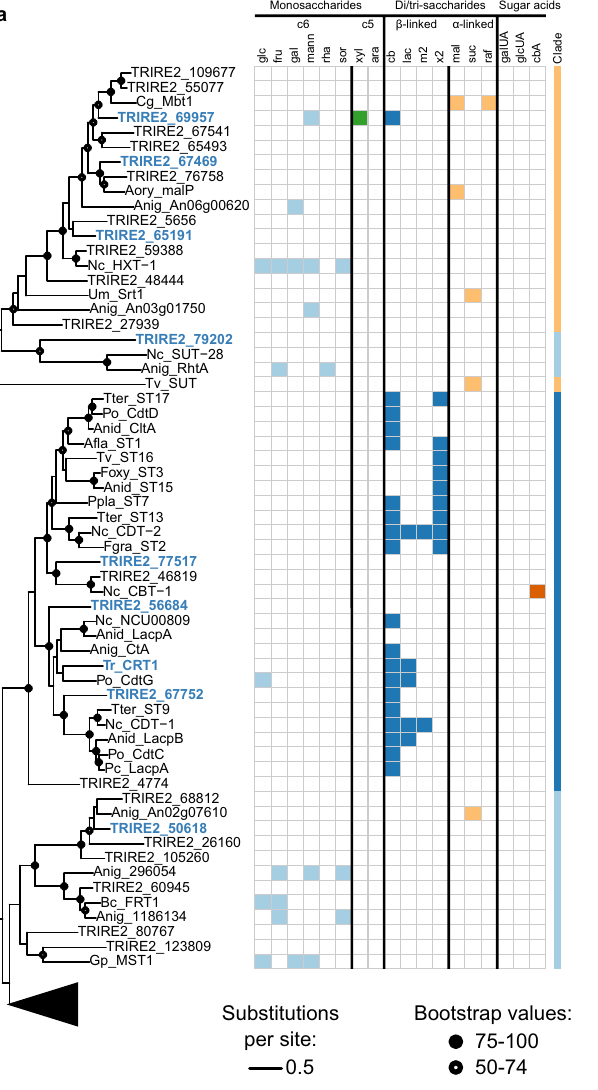
Figure 1. Phylogenetic tree of published sugar transporters from filamentous fungi and putative T. reesei sugar transporters. ( a, b ) Phylogenetic tree built from sequence alignment of published fungal sugar transporters and putative T. reesei transporters. ( b ) Presents the expansion of the hidden clade from ( a ). Known substrates of the transporters are indicated (References and organisms are listed in Supplementary Table S1). Substrates are divided into monosaccharides (c6: hexoses, c5: pentoses), disaccharides ( β - and α -linked) and sugar acids. T. reesei transporters which were selected for expression in oocytes are indicated in bold and with color. Scale bar presents substitutions per site and the symbols present bootstrap support values from 100 runs. Abbreviations: glc = d-glucose, fru = d-fructose, gal = d-galactose, mann = d-mannose. rha = l-rhamnose, sor = l-sorbose, xyl = d-xylose, ara = l-arabinose, cb = cellobiose, lac = lactose, m2 = mannobiose, x2 = xylobiose, mal = maltose, suc = sucrose, raf = raffinose, galUA = d-galacturonic acid, glcUA = d-glucuronic acid, cbA = cellobionic acid. The figure was created